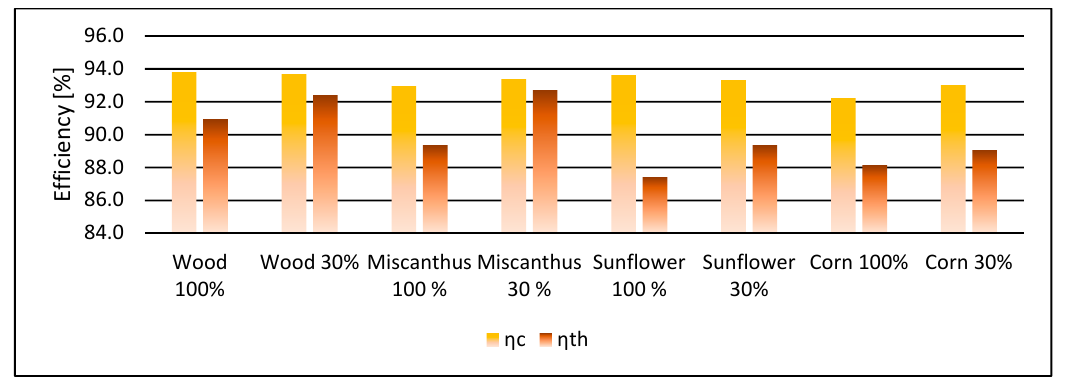
Figure 11. Comparison of dust emission from different types of pellets.